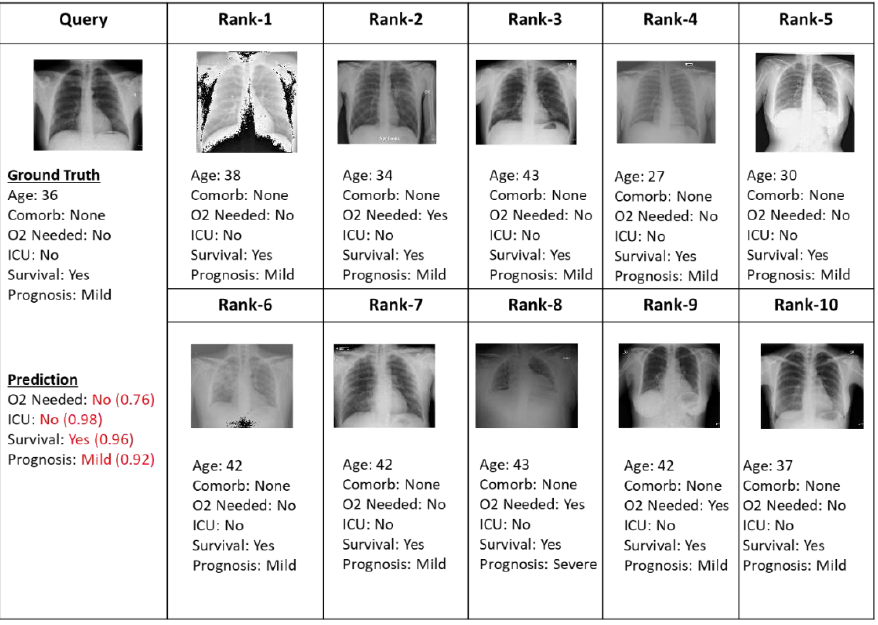
Figure 10. Top 10 relevant cases retrieved for the query case (Patient age = 36 years).